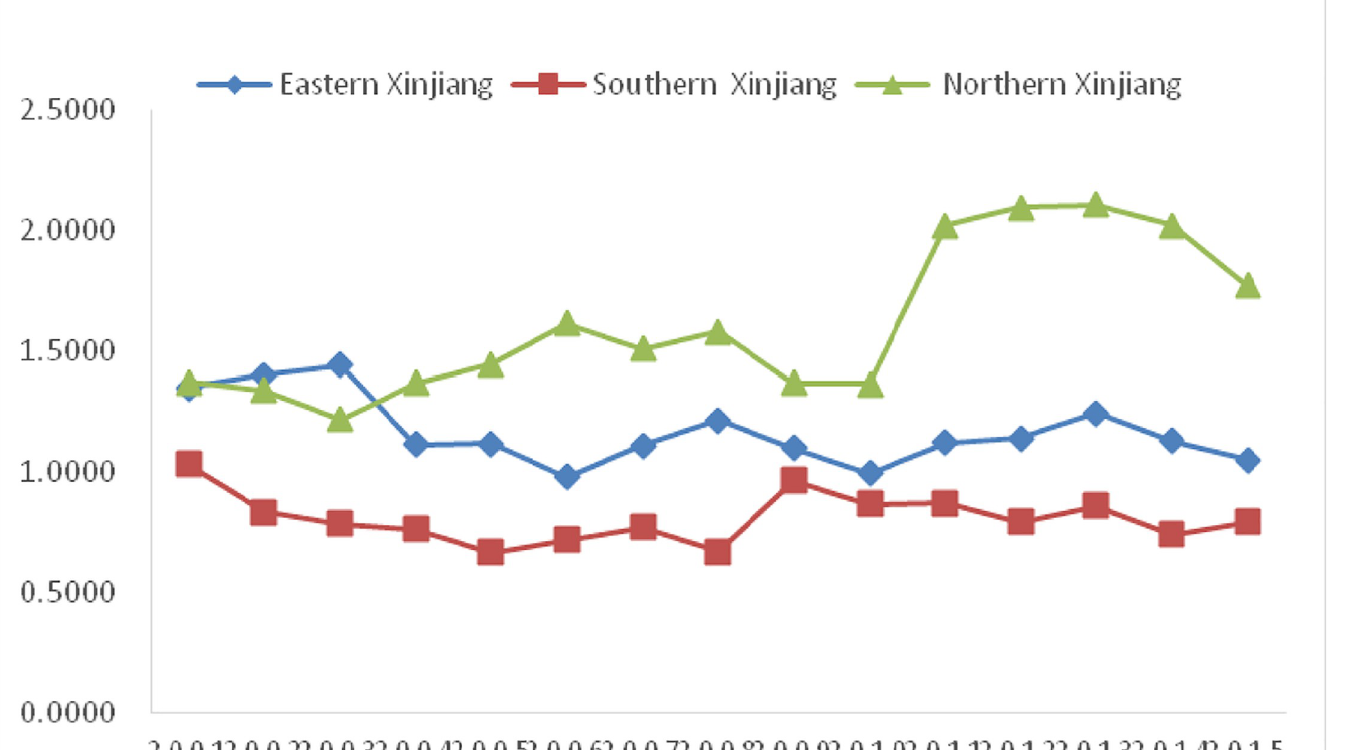
Fig 4. Variation trend of ecological efficiency in different regions of Xinjiang from